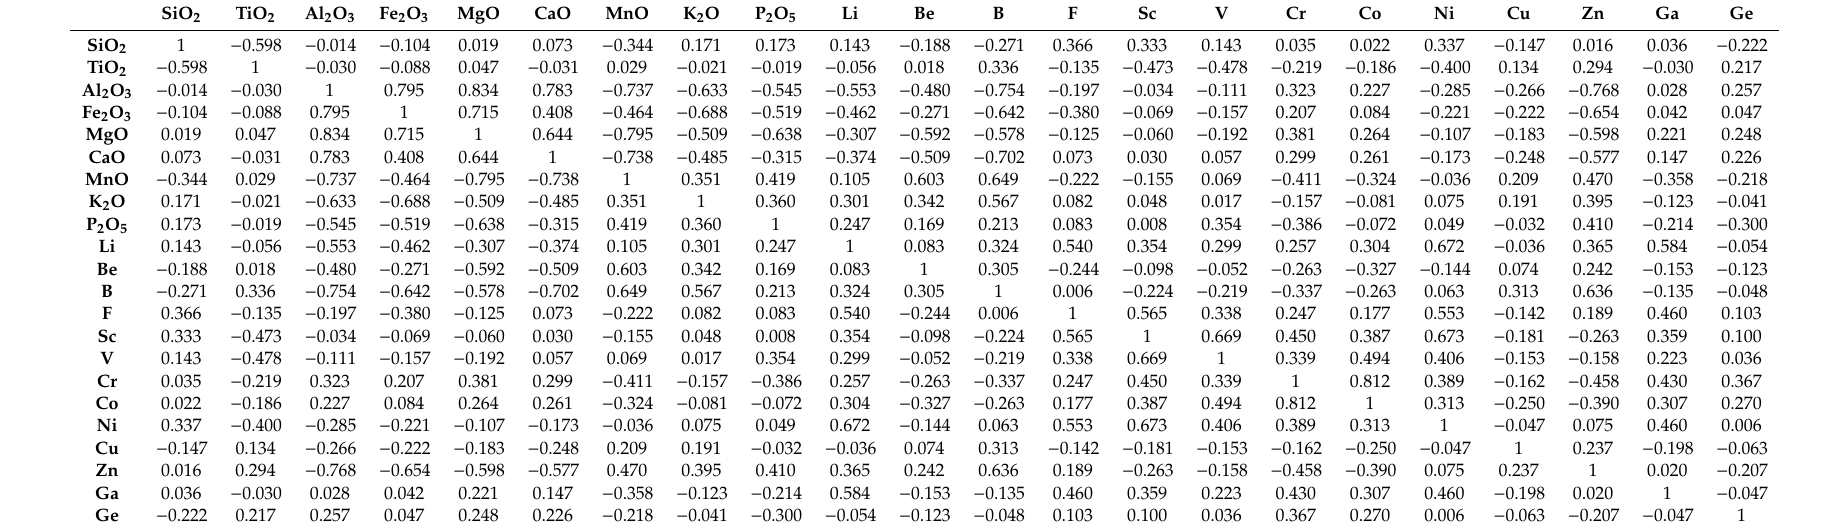
Table 4. Correlation using the ilr approach on coal and ash basis (Datanhao